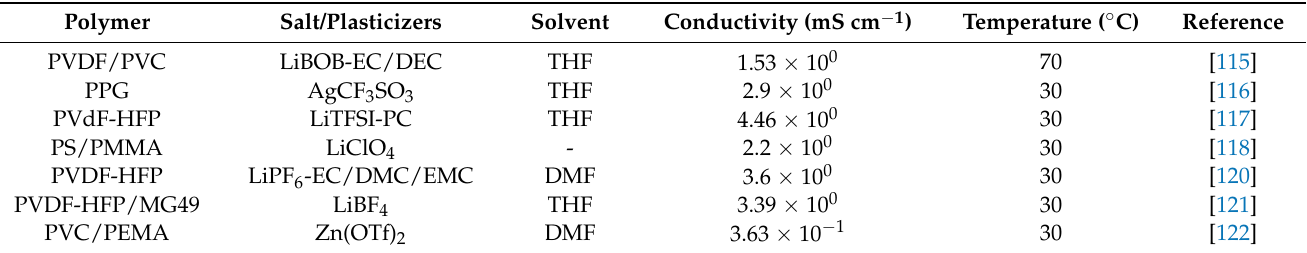
Table 4. List of GPEs with ZrO 2 filler with their conductivity and temperature.